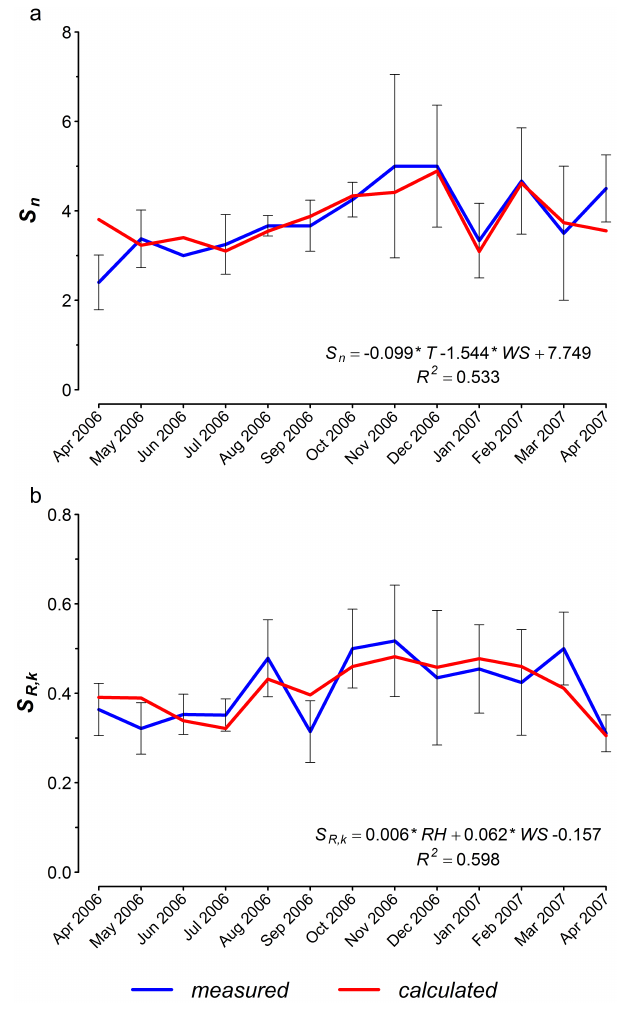
Figure 4. Time series depicting the most significant results from a multiple linear regression analysis between two diversity param- eters – normalized species richness per month ( S n ) and relative species diversity per month ( S R,k ) – and meteorological factors. The observed S n and S R,k curves (blue) were calculated with the equations given in Table S3. The modeled S n and S R,k curves (red) were calculated using the monthly averages of the corre- sponding meteorological factors in the equations depicted in the plots. (a) Time series of S n . Best variable subset: T and WS ( p value = 0.011), with error bars being SE n (S n ). (b) Time series of S R,k . Best variable subset: RH and WS ( p value = 0.022), with er- ror bars being SE n (S R,k ). RH : average relative humidity [%]; WS : average wind speed [ms − 1 ]; T : average temperature [ ◦ C].